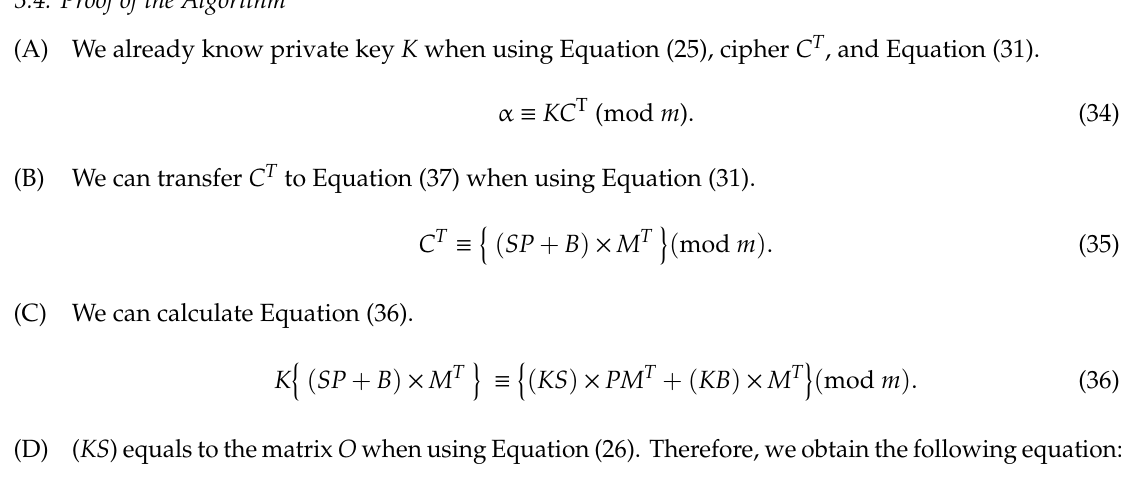
Figure 3. Key generation, exchange, and message encoding / decoding